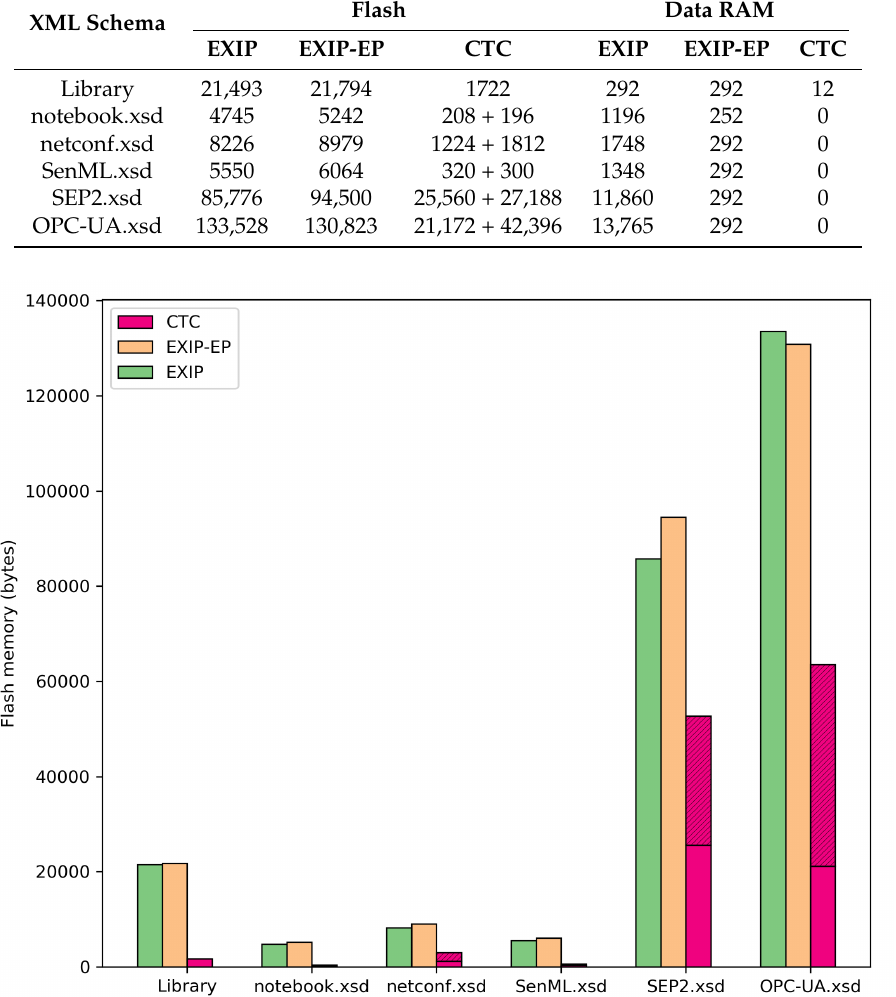
Figure 12. Flash memory consumption comparative in